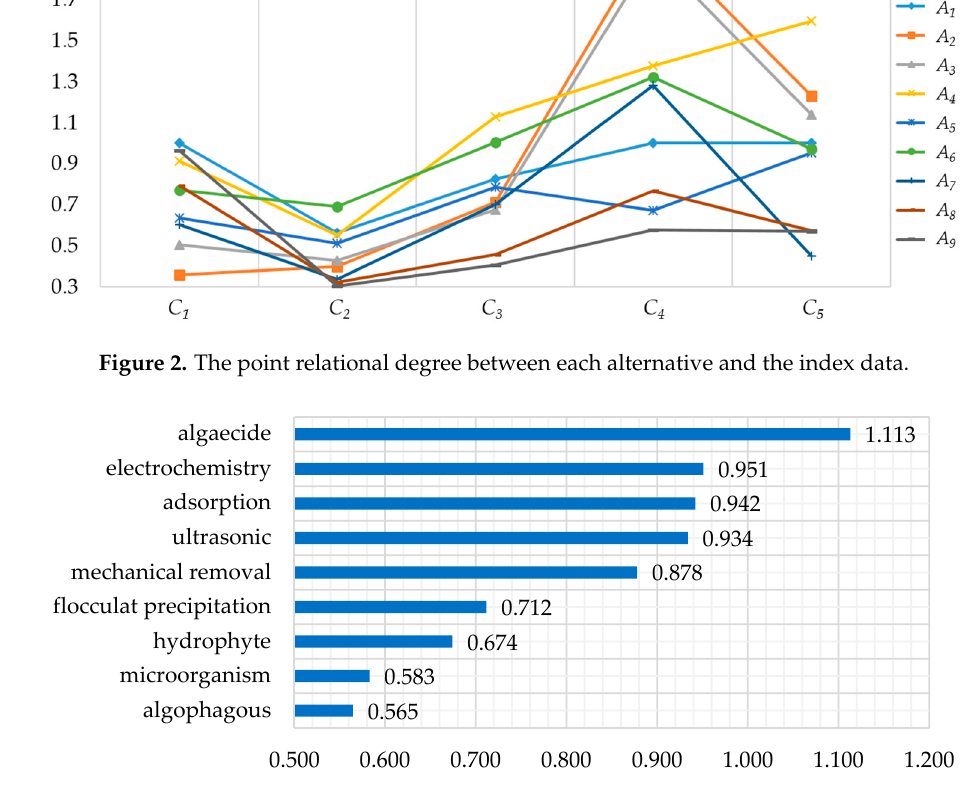
Figure 3. Rank of alternatives. The larger the value, the better the approach.